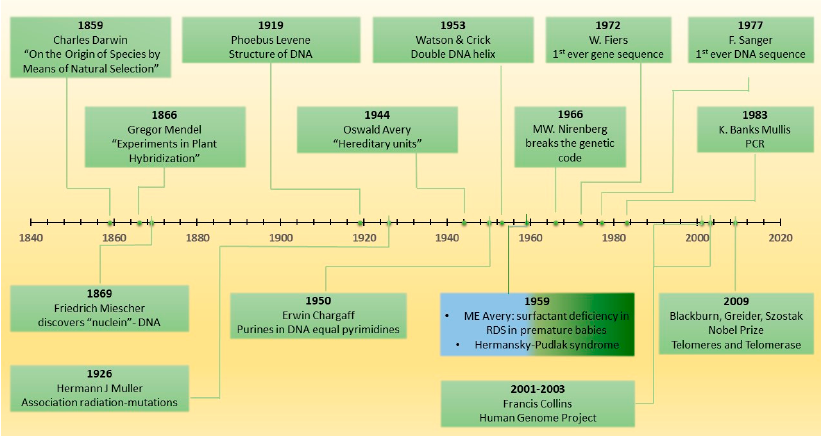
Figure 1. Major discoveries in the history of genetics: 1859: Ch. Darwin: “On the Origin of Species”; 1866: Gr. Mendel: Experiments in Plant Hybridization”; 1869: Fr. Miescher: “nuclein” (DNA); 1919: